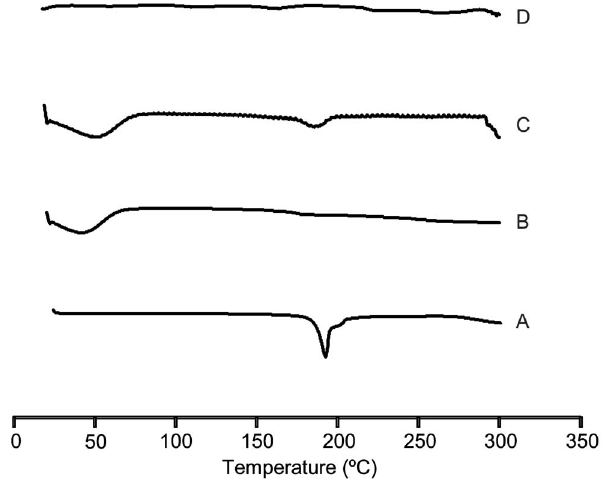
Figure 1. DSC thermograms. A: ABZ (pure drug), B: RM- b -CD, C: ABZ:RM- b -CD obtained by physical mixtures, D: ABZ:RM- b -CD obtained by spray drying.